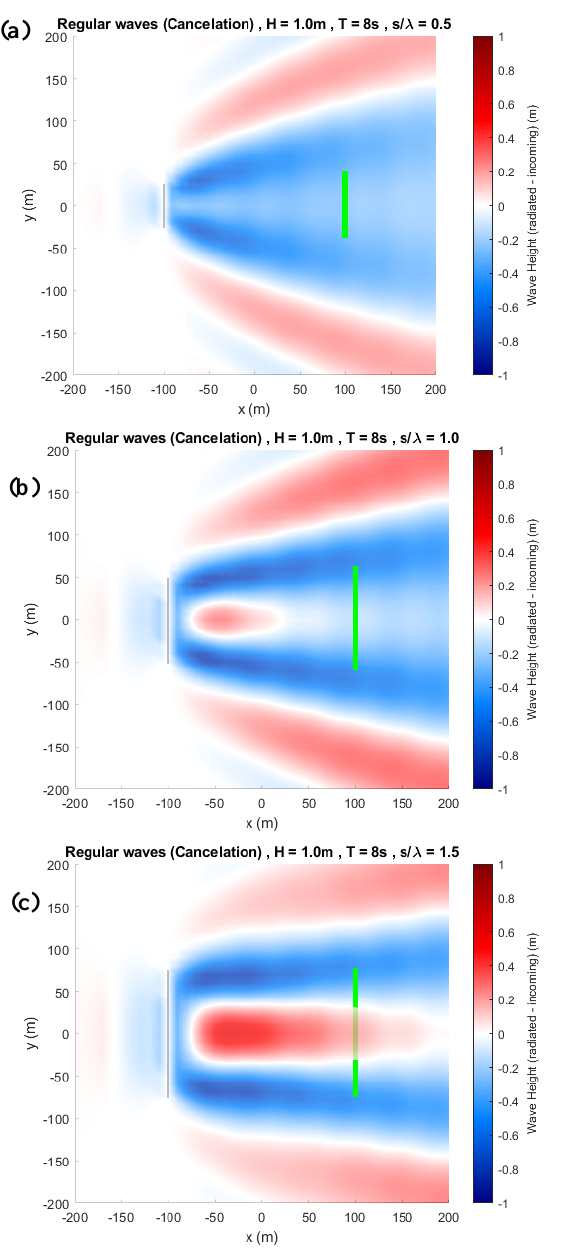
Figure 13: The wave height of the resulting (cancelation) wave field assuming regular wave condition for different spans, (a) 𝑠 𝜆⁄ = 0.5 and (b) 𝑠 𝜆⁄ = 1.0 . Green solid line represents the capture